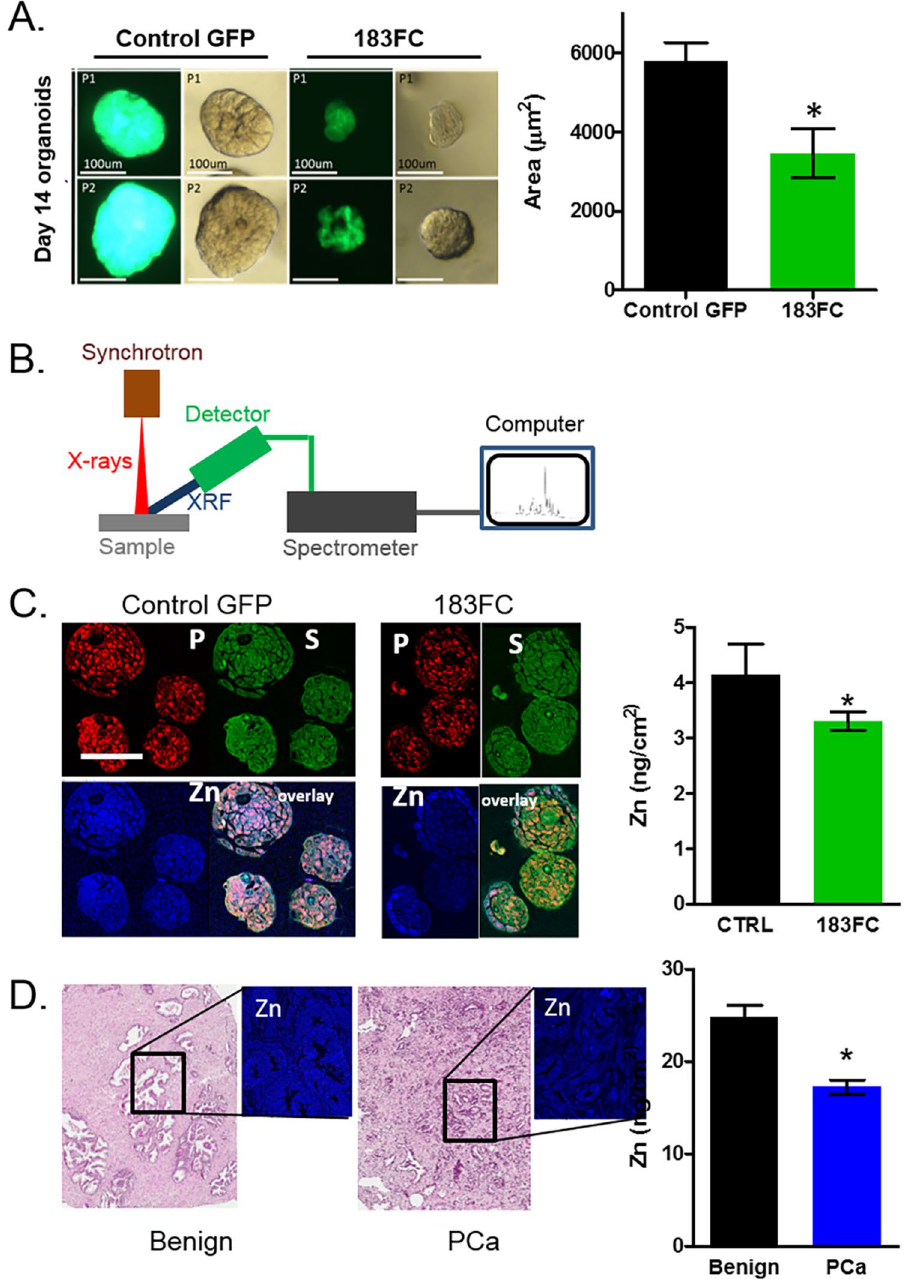
Figure 3. Overexpression of 183FC in benign human prostate epithelial organoids emulated decrease in zinc observed in human PCa as measured by X-ray fluorescence (XRF). ( A ) Size of 14 day organoids transduced with control-GFP or 183FC. Two individual PrE patient-derived cell lines are shown (P1 and P2) of n = 4 total patients. ( B ) Schematic of x-ray fluorescence measurement at Argonne National Lab (full detail in Supplemental Fig. 1). ( C ) Images and quantitation of the fluorescence of the elements sulfur (S), phosphorus (P), and zinc (Zn) in 14 day benign organoids (n = 4) transduced with control-GFP or 183FC scanned with x-rays. Zinc levels were quantified by ROI’s drawn to encompass the entire organoid. Graphs show mean zinc per area of each of the organoids. ( D ) H&E image and quantitation of the fluorescence of zinc (Zn) in benign and PCa patient tissue scanned with x-rays. Quantitation based on 10 ROIs for each tissue. All graphs show mean with SEM, * < 0.05 by Student’s unpaired 2-sided